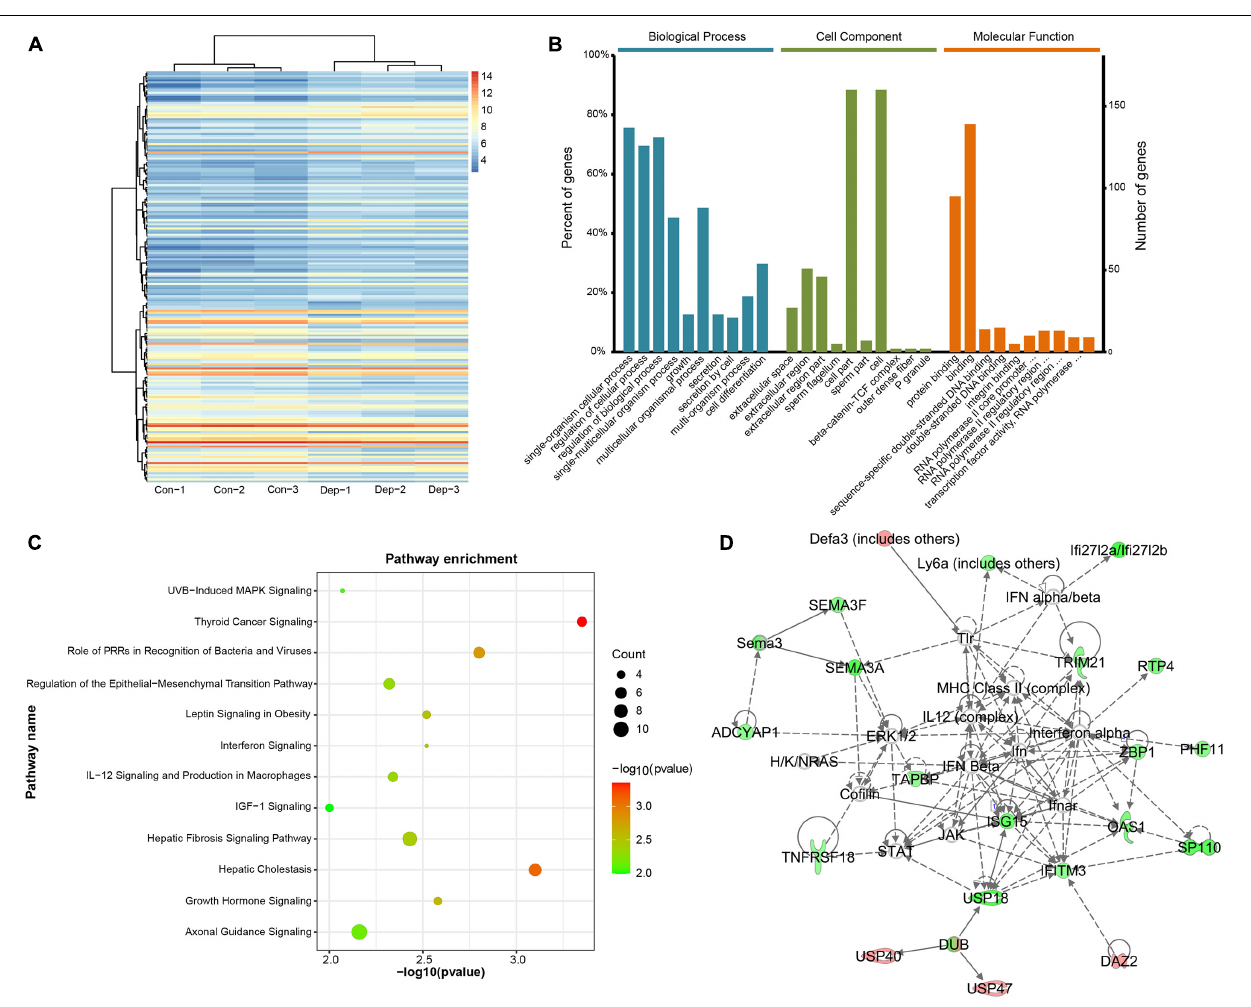
FIGURE 1 | Identification and functional analysis of differentially expressed mRNAs (DEGs) in gut microbiota-dysbiosis mice. (A) Hierarchical clustering of DEGs. (B) Gene ontology (GO) annotations of DEGs. (C) Canonical pathway enrichment for DEGs analyzed by Ingenuity Pathway Analysis (IPA) software. (D) Functional network analysis for DEGs revealed by IPA